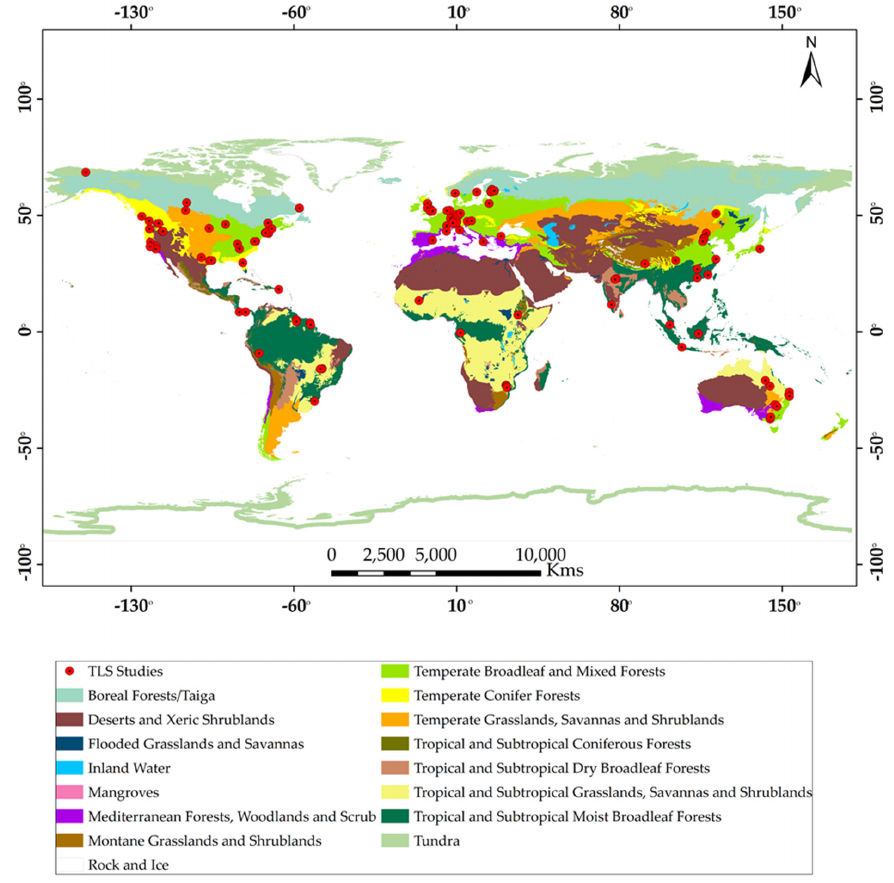
Figure 3. Geographic distribution of reviewed studies. Biome classification according to Olson et al. [93].